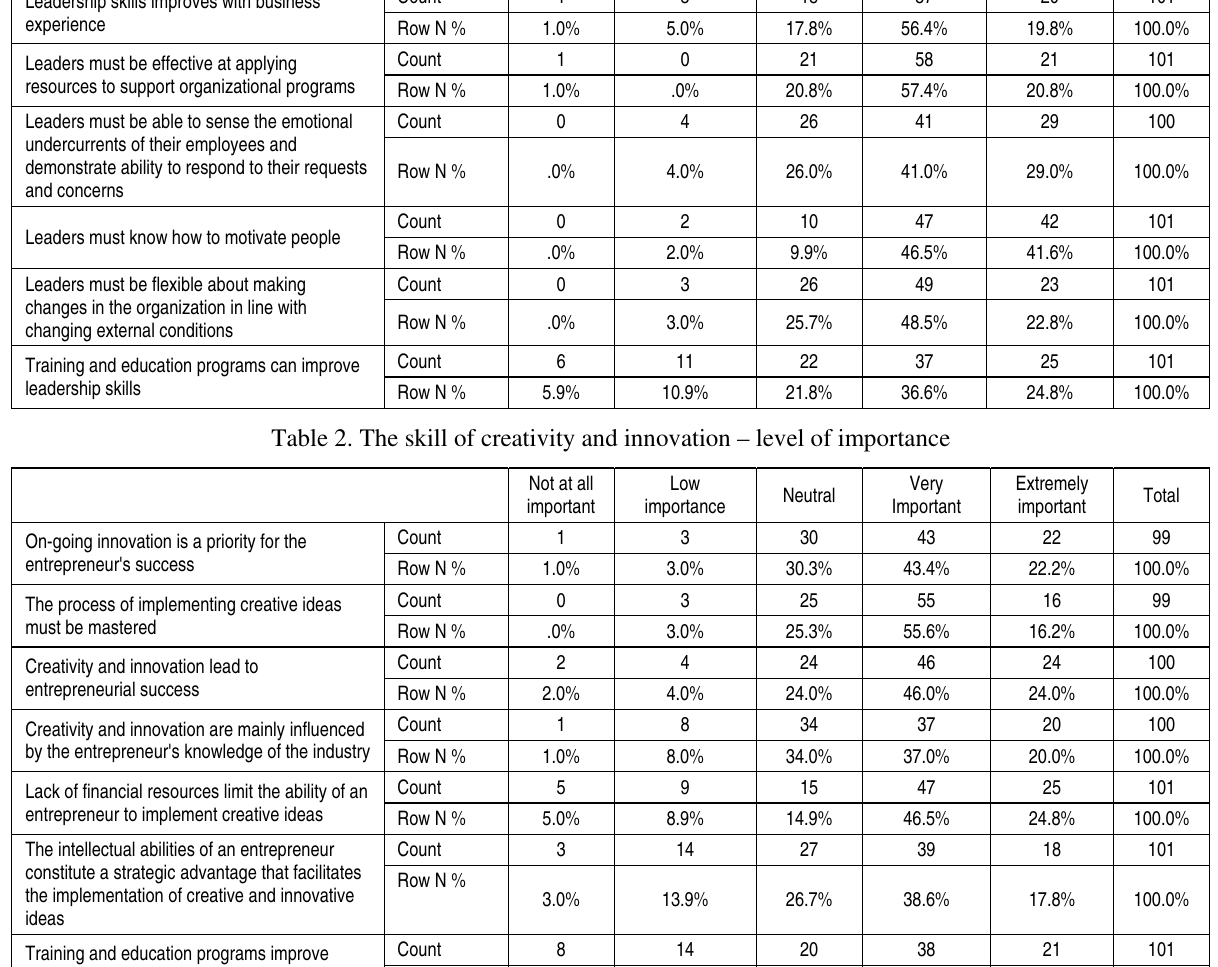
Not at all Low Very Neutral important importance important